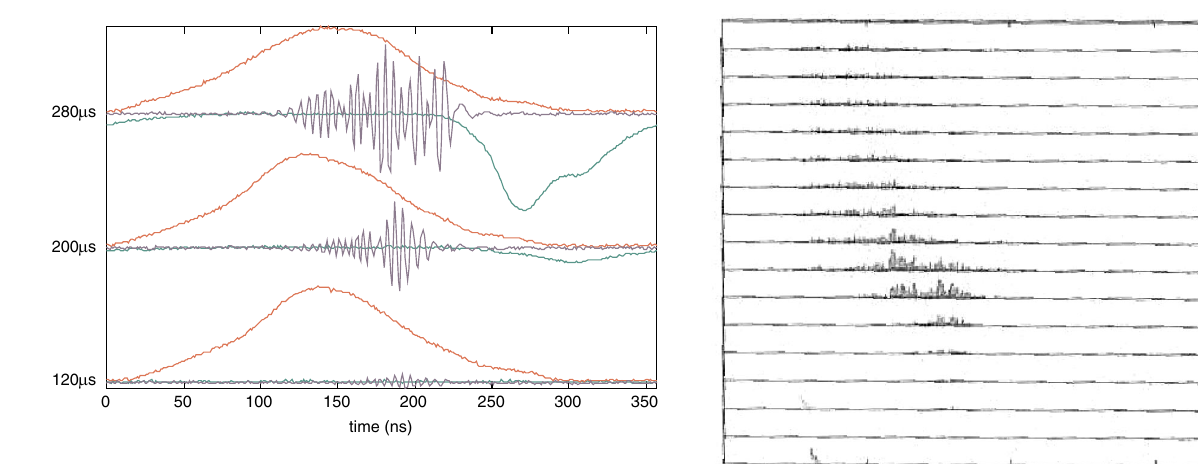
FIG. 10. (Color) Evolution of the vertical PSR instability; red Gaussian-like trace is the beam current, blue oscillating trace the vertical beam position (difference signal), and the green negative curve the electron current measured by a detector at the wall; from bottom to top the traces were obtained 120, 200, and 280 (cid:7) s after the end of accumulation; the beam charge is 4 : 4 (cid:7) C .